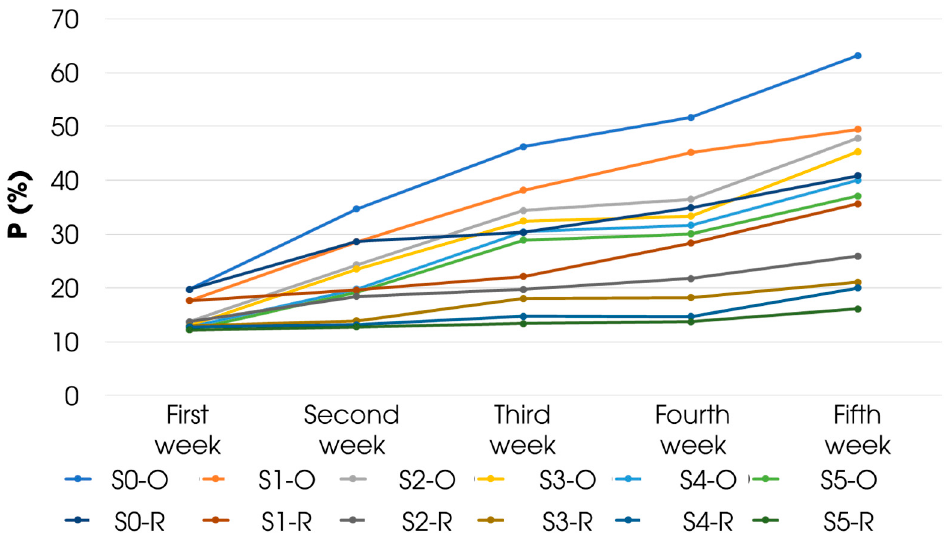
Figure 11. The polymeric anthocyanin content was at room temperature and at 45 ◦